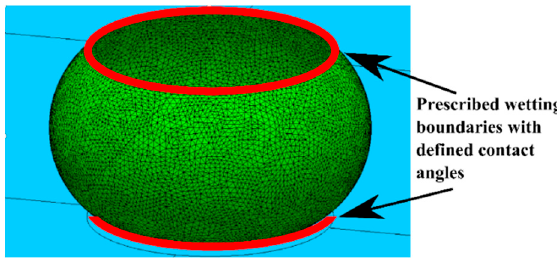
Figure 3. An example of the simulation boundaries. Inside the red lines, the surface energy is defined by low contact angle (10°). Outside the red lines, high surface energy is defined by large contact angle (110°–165°).